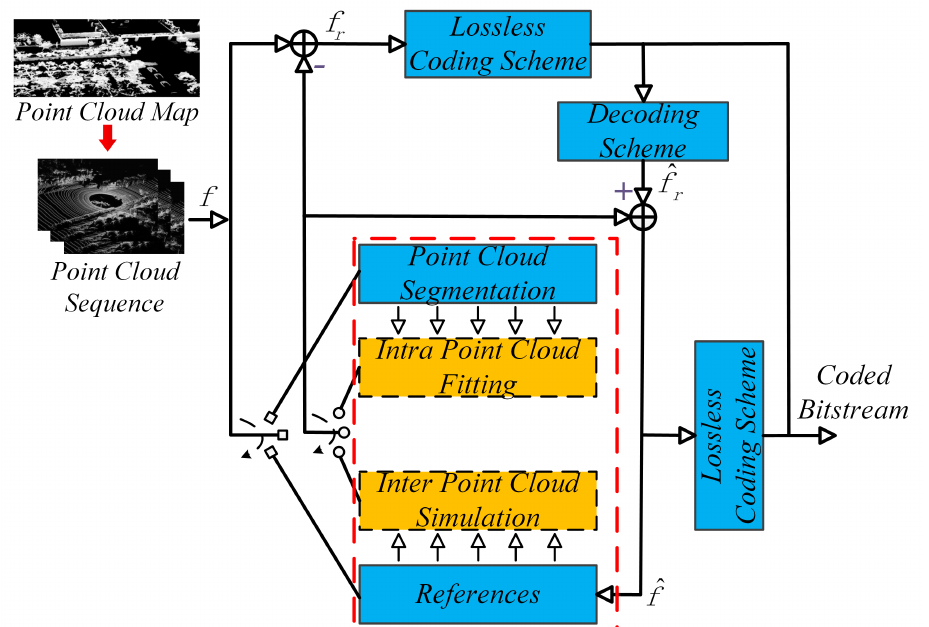
Figure 1. System architecture of our LiDAR point cloud map